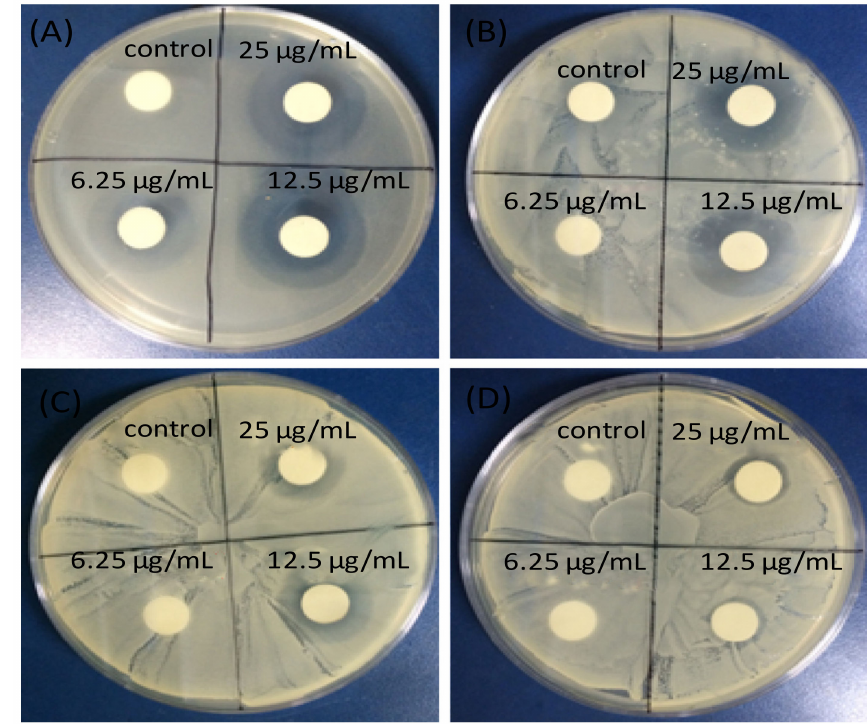
Figure 9. Inhibitory zones of ZnO-GO nanocomposite against ( A ) Escherichia coli ; ( B ) Salmonella typhimurium ; ( C ) Bacillus subtilis ; ( D ) Enterococcus faecalis . Adapted from Ref. [91], with permission from Dove Medical Press,